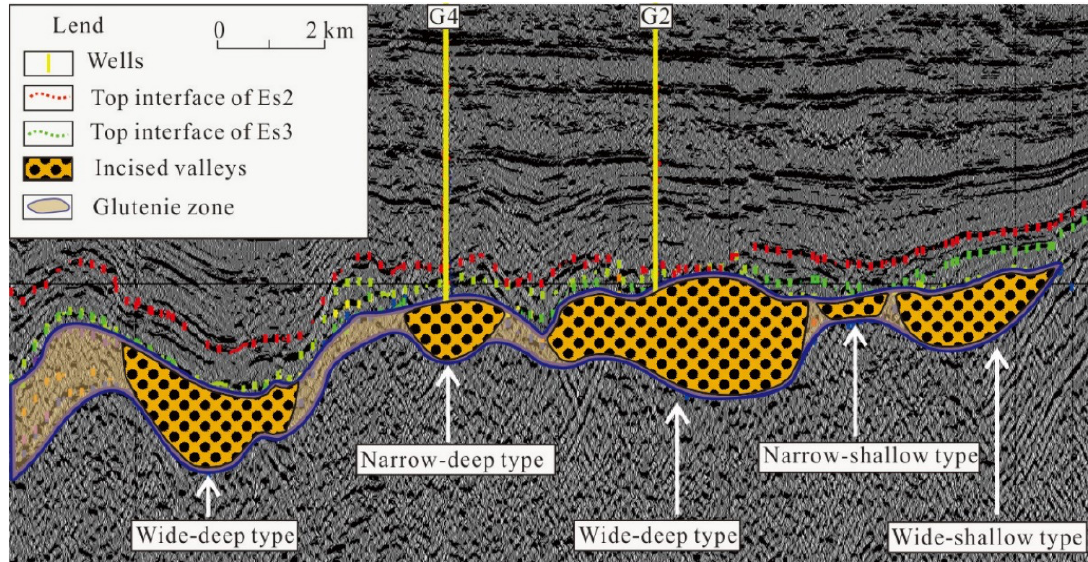
Figure 6. Types of incised valleys in the steep slope zone of the Guojuzi area